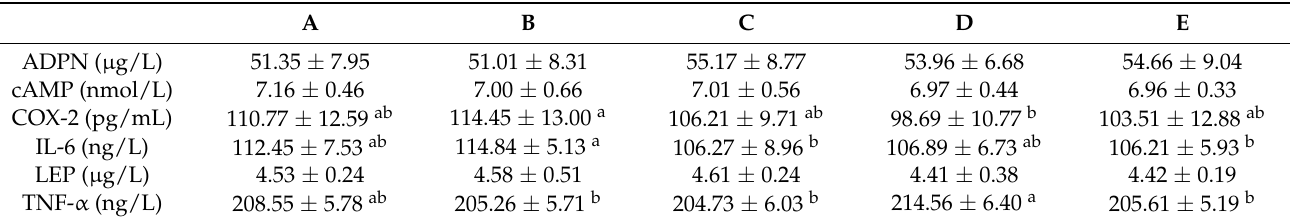
Values of the same indexes in the same line with small letter superscripts mean significantly different ( p < 0.05).